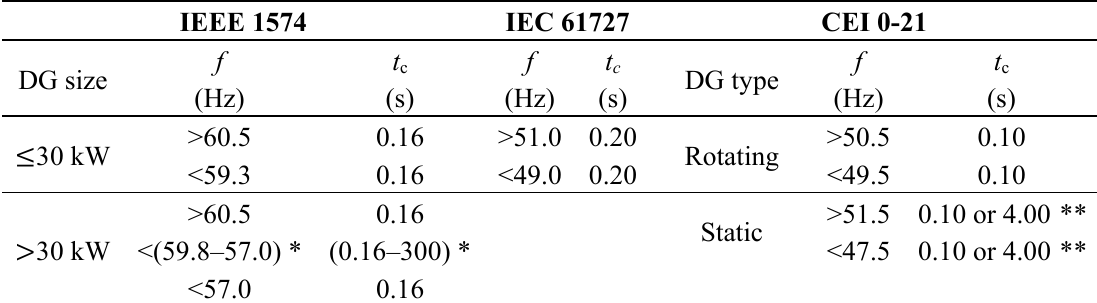
Table 2. Frequency requirements for LV distribution